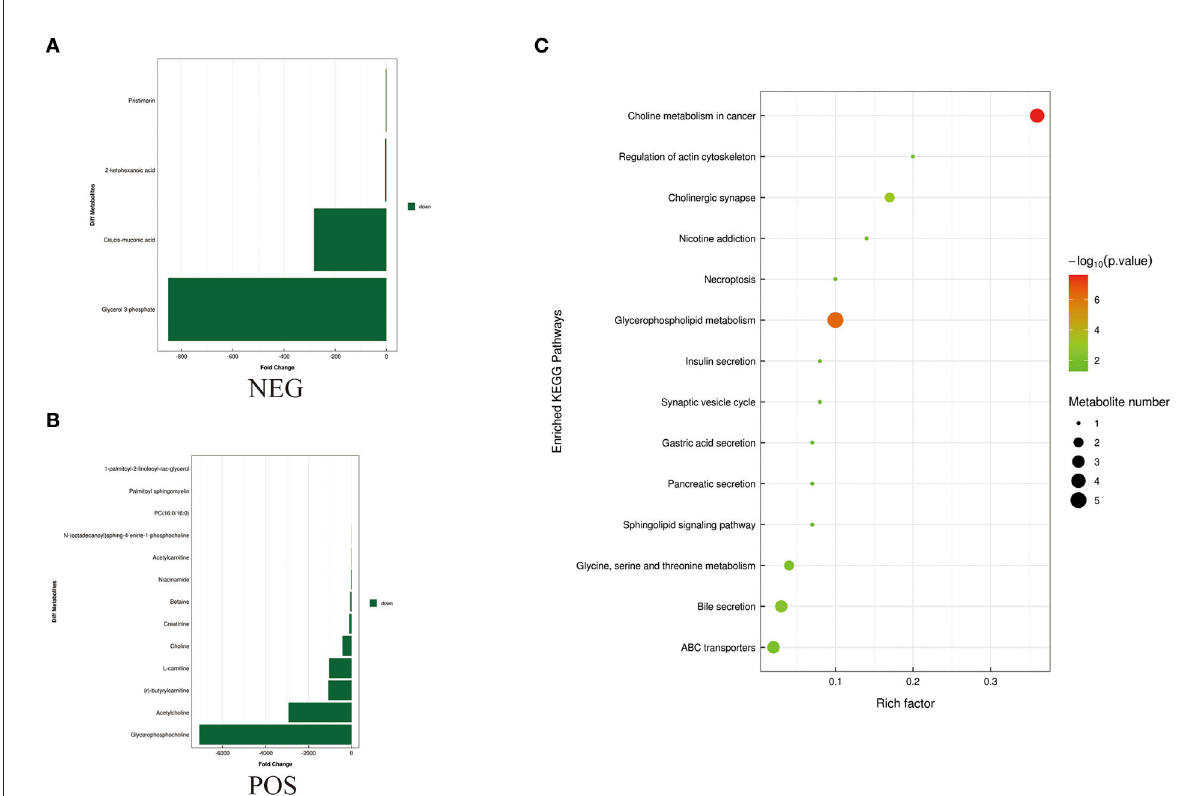
FIGURE5 Metabolites identified in sperm by OPLS-DA model VIP > 1. (A, B) Was detected in negative and positive ions mode, respectively. (C) KEGG analysis of the differential metabolites in sperm of Duroc and Liang guang Small-spotted pig. The bubble size indicates the influencing factor in the topological analysis; the bubble color represents the P -value of enrichment